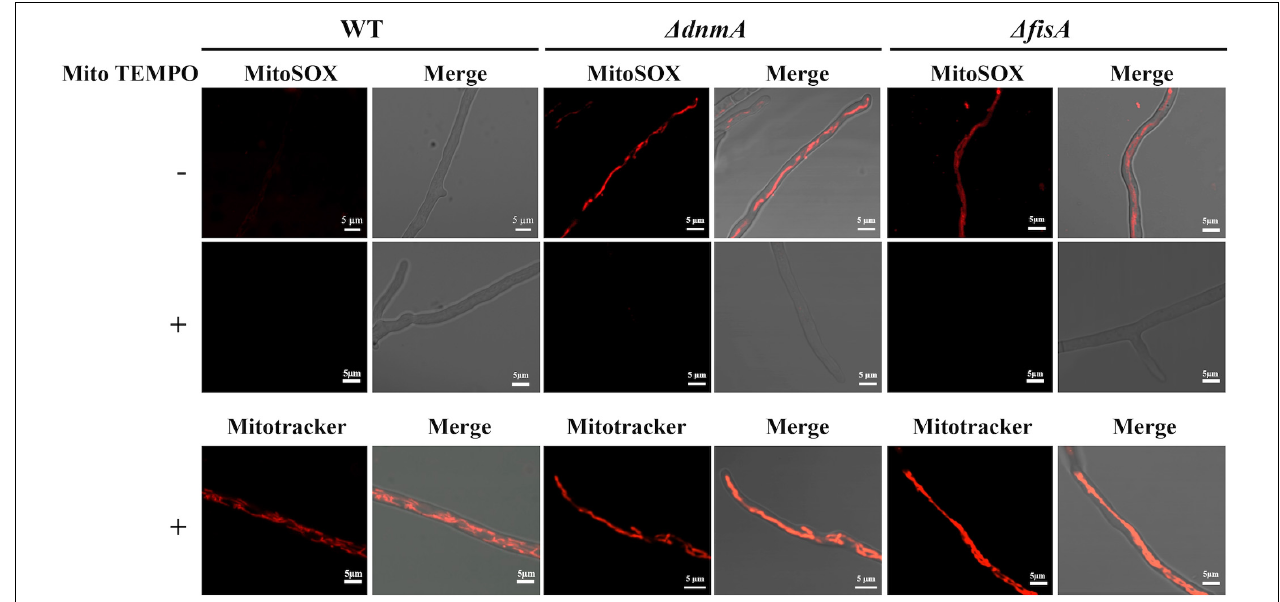
FIGURE 10 | Pretreatment with Mito TEMPO prevents MitoSOX but not Mitotracker staining of (cid:49) dnmA and (cid:49) fisA mitochondria. Mycelia from strains 1155 (WT), TVG1 ( (cid:49) dnmA ), and TVG2 ( (cid:49) fisA ) grown for 14 h in supplemented glucose minimal medium were incubated with Mito TEMPO for two h at 37 ◦ C and then stained with either MitoSOX or Mitotracker, as indicated in section “Materials and Methods,” and then observed by using confocal microscopy.